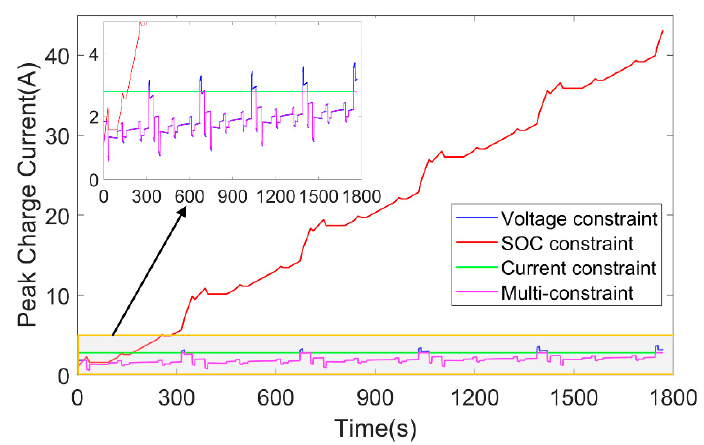
Figure 24. Multi-constrained battery charge peak current curve.